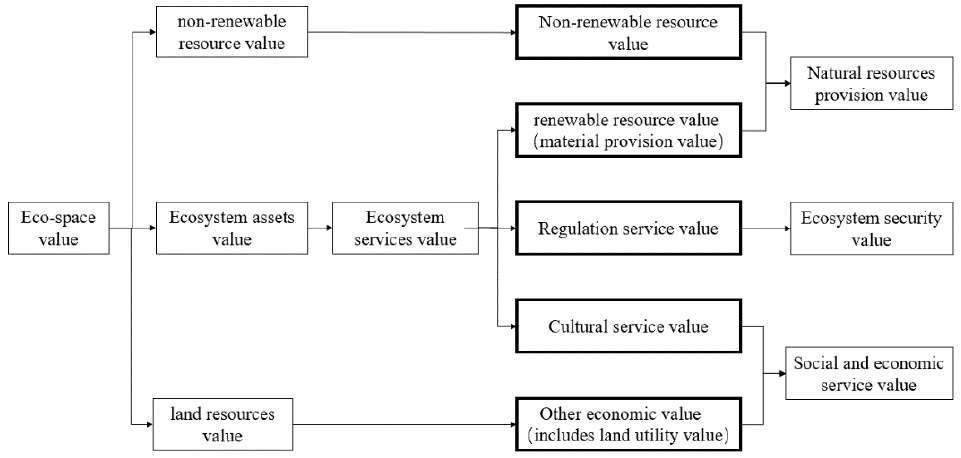
Figure 1. Eco-space value composition.